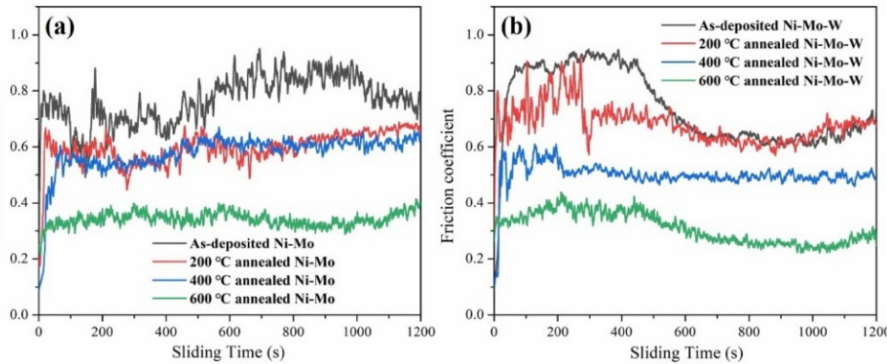
Figure 8. The curves of friction coefficient vs. sliding time for as-deposited and 200 to 600 ◦ C annealed: ( a ) Ni-Mo coatings; ( b ) Ni-Mo-W